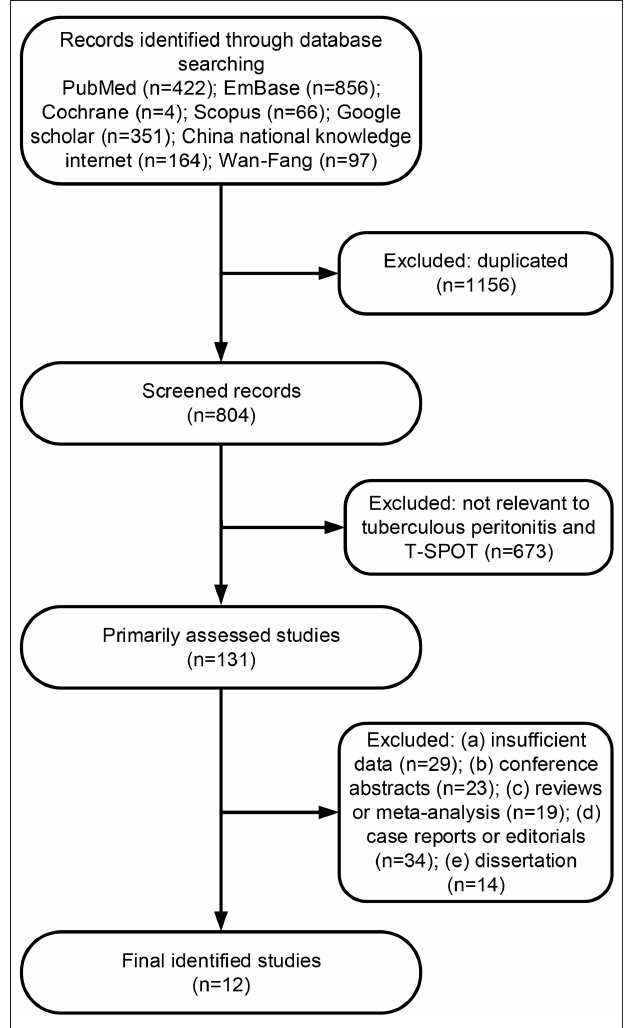
FIGURE 1 | Flowchart diagram of the literature search